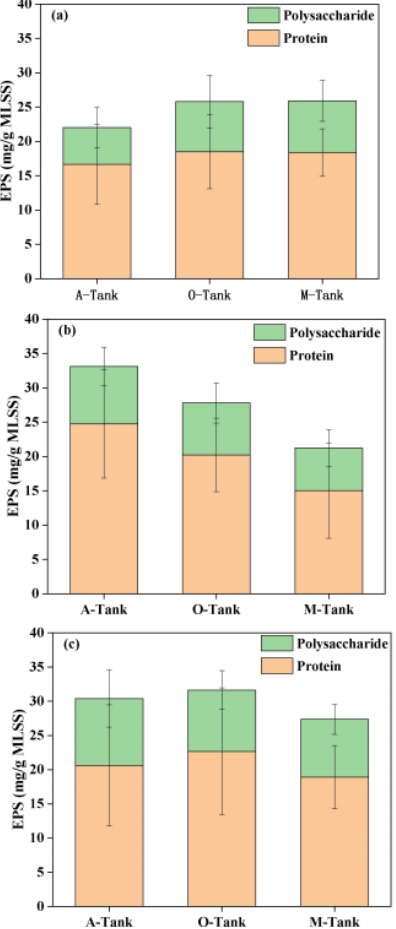
Figure 3. Total EPS in terms of polysaccharides and protein in different tanks of three bioreactors, MBR control ( a ), AOA S150 ( b ), and AOA S300 ( c ).